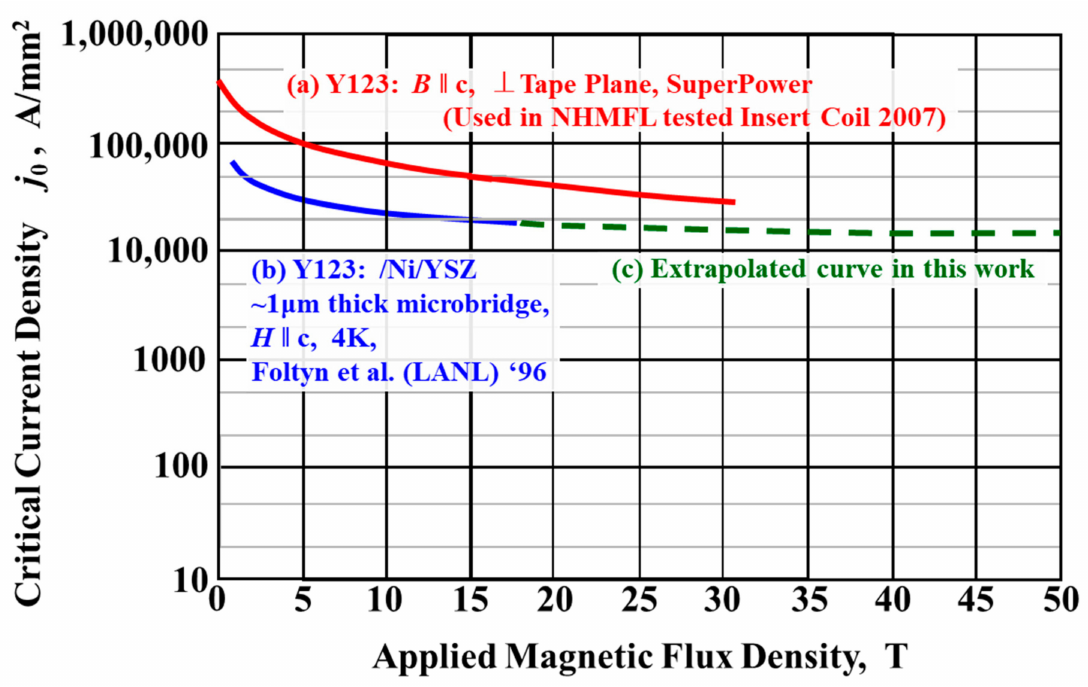
Figure 4. Experimentally obtained dependences of j c on the magnetic flux density in Y123 thin films reported in [28,29] ( a ) and in [30] ( b ). ( c ) A supposed extended curve of ( b ) beyond 18